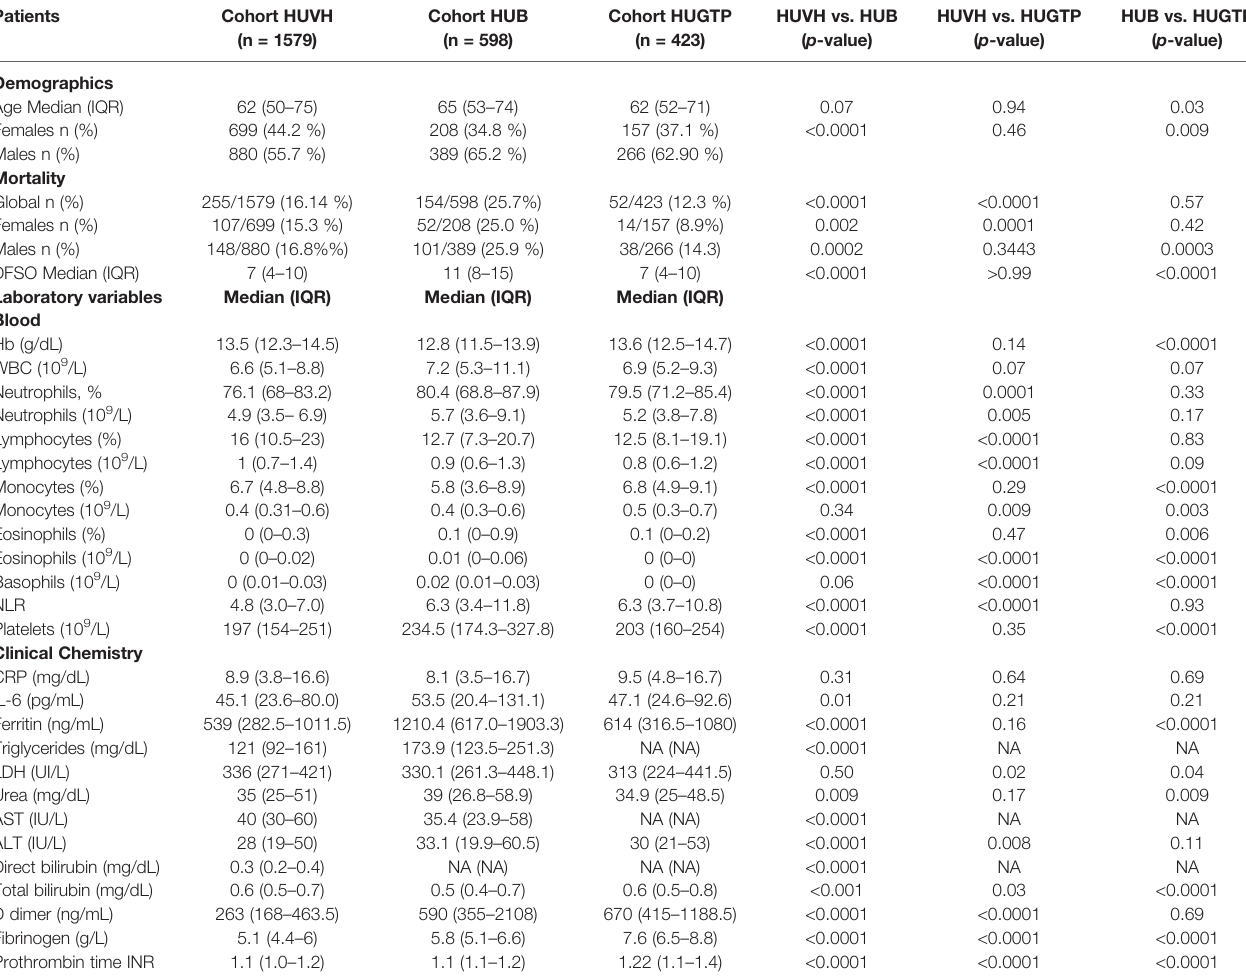
TABLE 6 | Pairwise comparison of demographic and clinical laboratory biomarkers in the exploratory (HUVH) and the two validation cohorts (HUGTP and HUB). Patients Cohort HUVH (n =